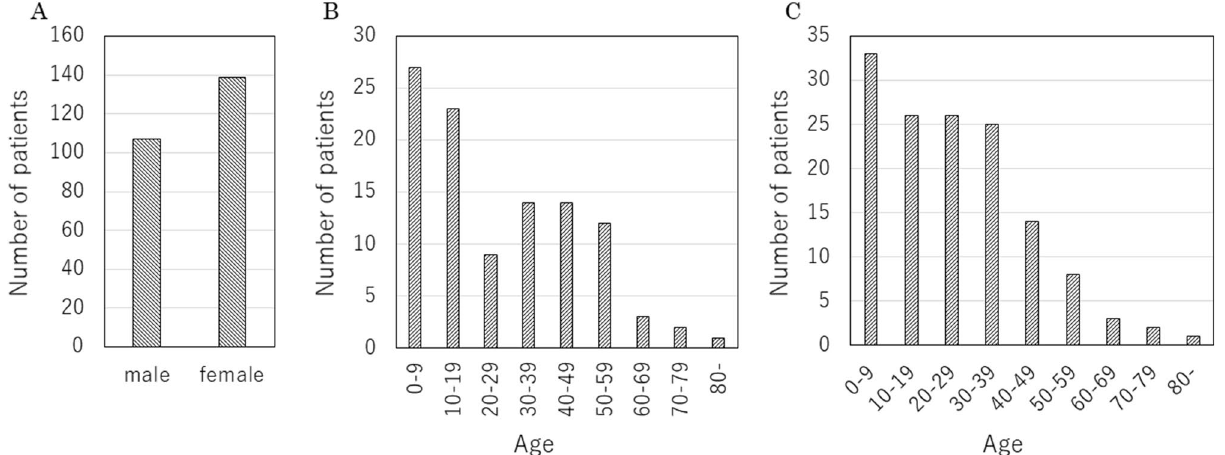
Figure 3. Number of NF1 patients by gender. ( A ) total, ( B ) male by age group at first visit, ( C ) females by age group at first visit.